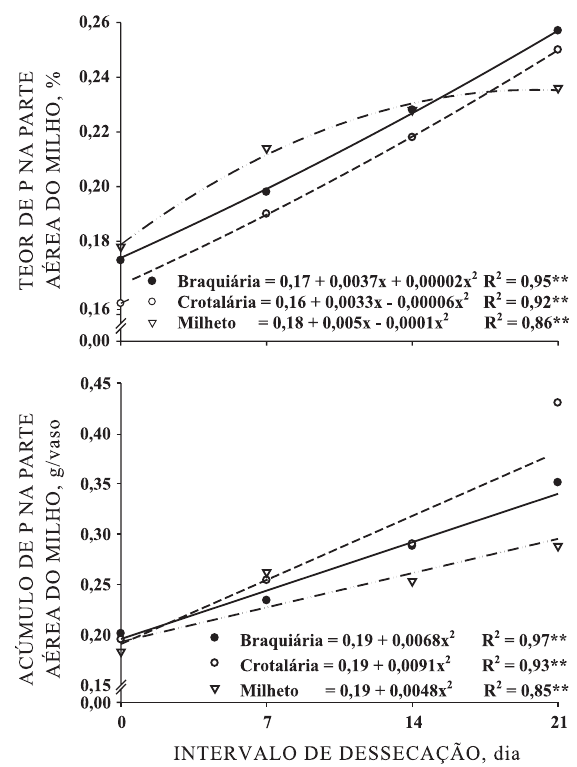
Figura 5. Teor e acúmulo de fósforo na planta de milho, em função do intervalo de dessecação, em diferentes espécies de plantas de cobertura.